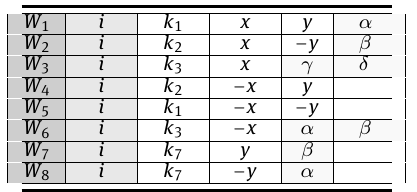
Table 5. Partial index distribution of the codewords of G i .